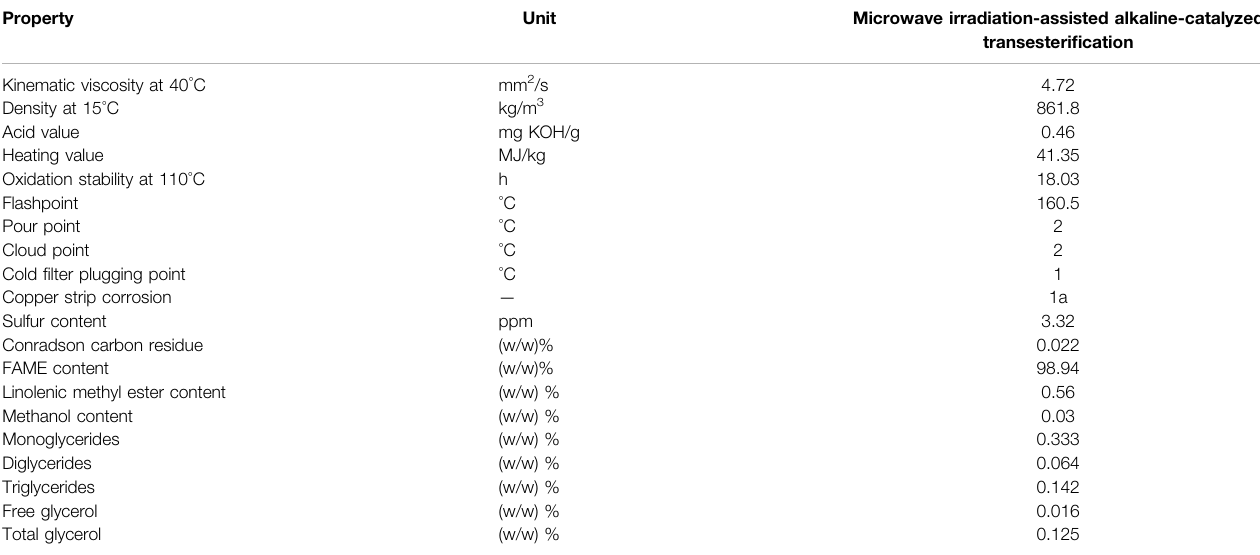
TABLE 3 | Physicochemical properties of biodiesel produced from microwave irradiation-assisted alkaline-catalyzed transesteri fi cation. Property